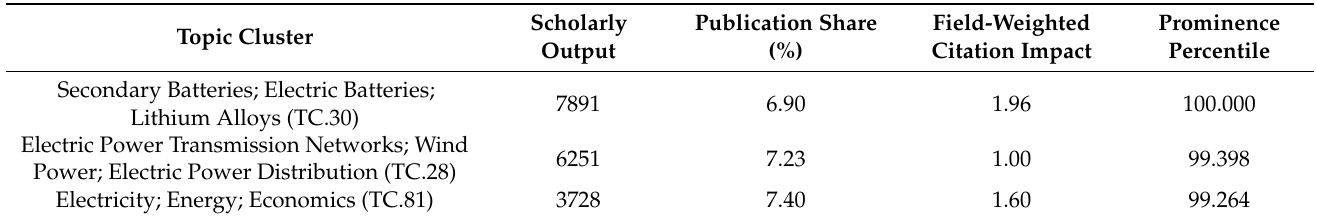
Table 1. Top 1% of worldwide clusters by prominence that appear within renewable energy, sustainability and the environment, 2020–2021.